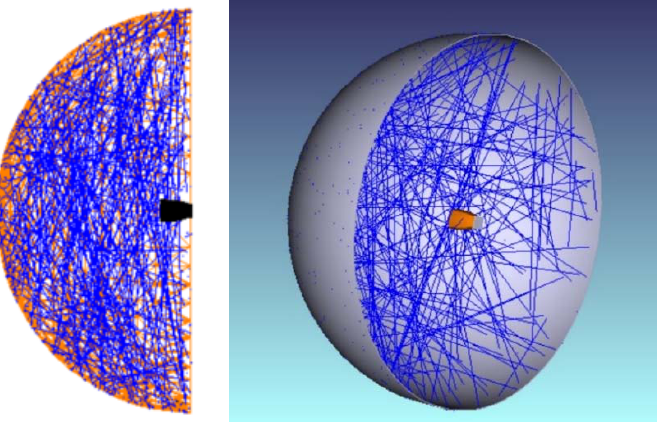
Figure 4. Simulation setup for diffuse analysis; side view (left), and isometric view (right).